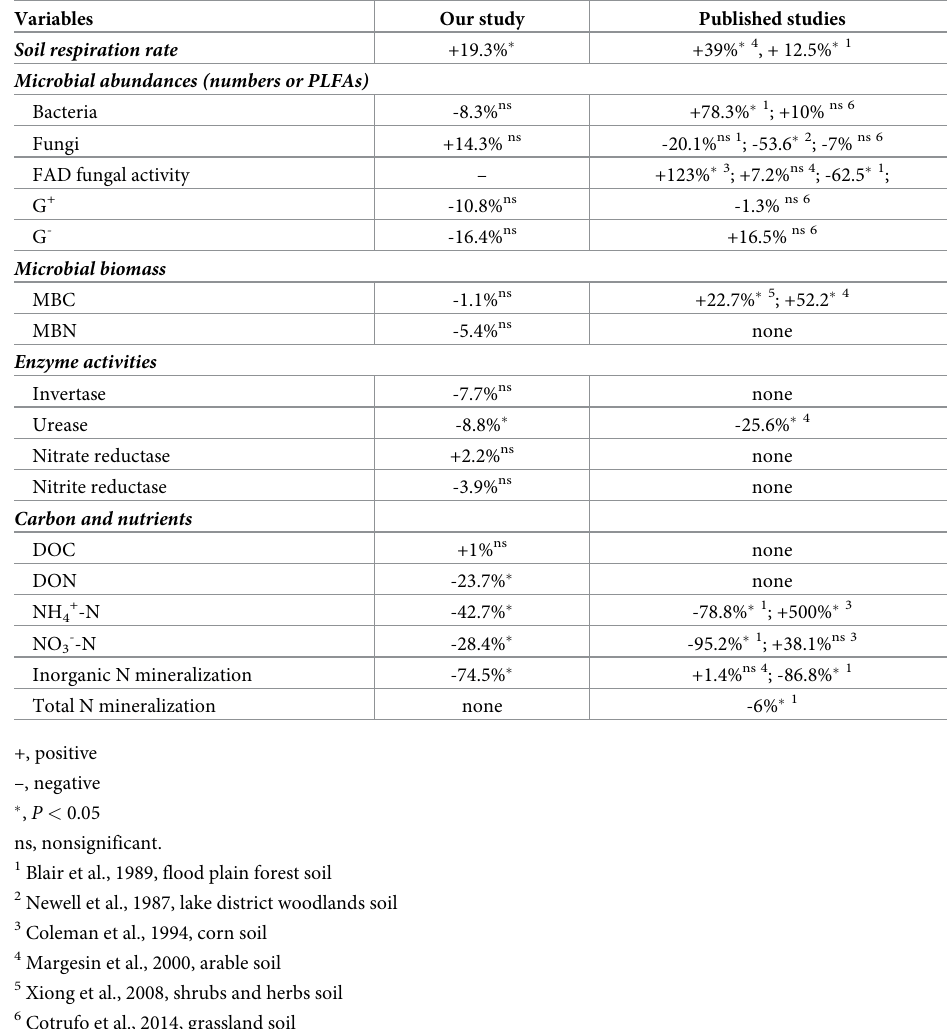
Table 3. Differences in the non-target effect of naphthalene additions on soil biochemical properties between in our study and six published